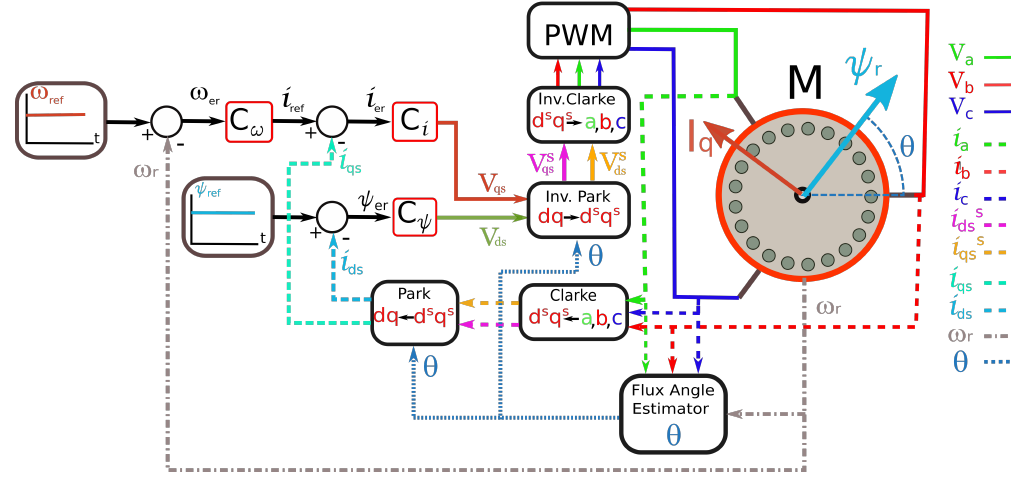
Figure 1. Velocity Field-Oriented